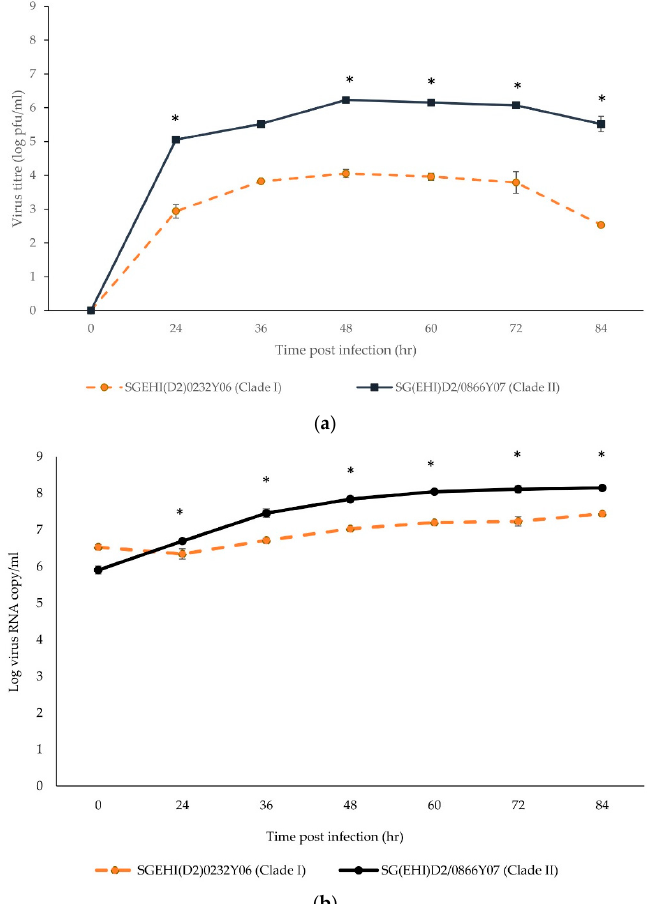
Figure 3. Growth kinetics of DENV-2 strains in K562 cells. Cells infected with clade I and II isolates (M.O.I = 5) were incubated for six days. The data show means of triplicates and are representative of two independent experiments. ( a ) Virus titers in supernatants were quantitated by plaque assay and expressed as logPFU/mL. Asterisk represents p < 0.002. ( b ) Viral copy numbers in supernatants were determined by RT-PCR. Asterisk represents p < 0.0.05. Error bars indicate ± S.E.M. 3.3. Clade II Produced Lower Percentage of Apoptotic Cells Flow cytometry analysis showed that clade II induced a lower percentage of apop- totic cells than the clade I isolates at 24 hpi and 48 hpi (Figure 4A,B), but the differences were not statistically significant. The apoptotic rate of the clade I isolate showed a strong positive correlation with the infection rate (Pearson correlation coefficient = 0.75, p < 0.001) during 48 hpi, whereas the clade II isolate demonstrated a weak correlation between the two parameters (Pearson correlation coefficient = 0.45, p = 0.01).